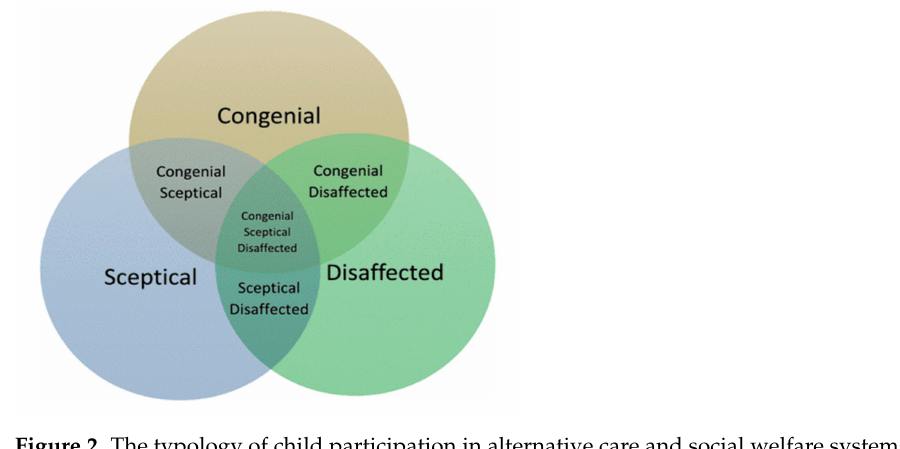
Figure 2. The typology of child participation in alternative care and social welfare systems